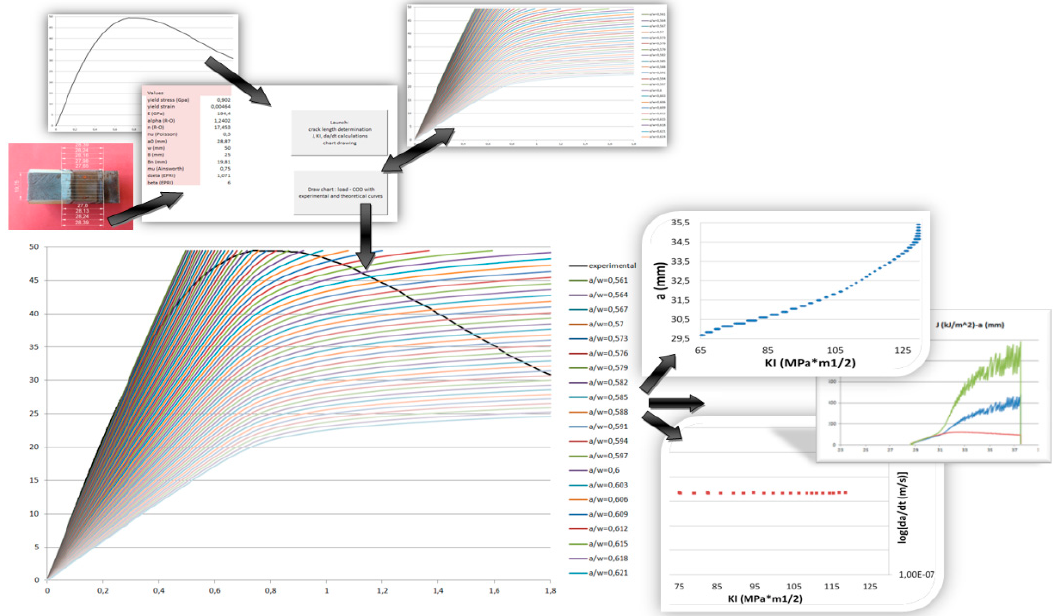
Figure 1. Example of the implementation of GE-EPRI methodology [3,4,15].